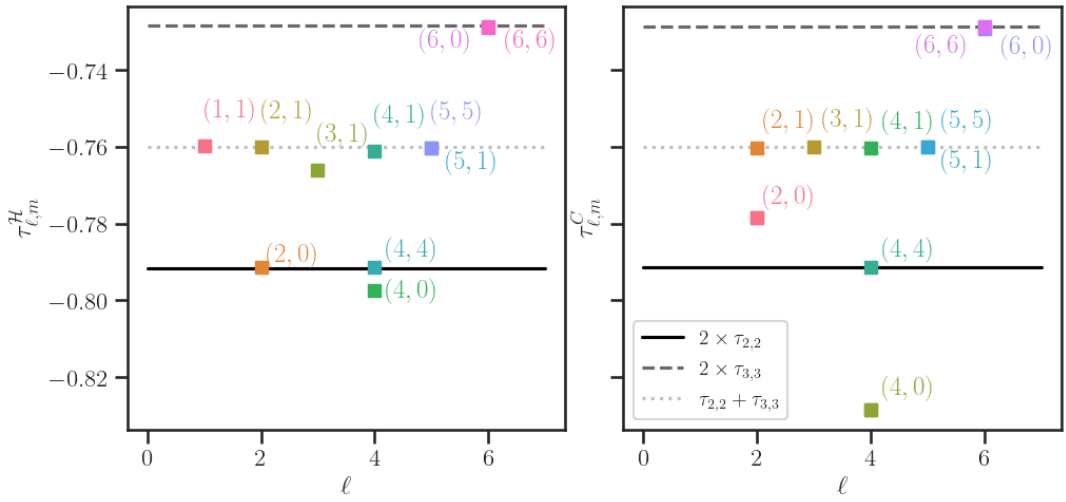
Figure 6 . Decay rates for the Hajiceck degrees of freedom (left) and the metric perturbation (right) for the angular modes. The lines denote the expectation for the decay rates of the non- linearly excited modes, 2 τ (black, solid), 2 τ (dark gray, dashed), τ + τ (lighter gray, (2 , 2) (3 , 3) (2 , 2) (3 , 3) dotted). Each square denotes the position of a mode, as indicated in the figure.